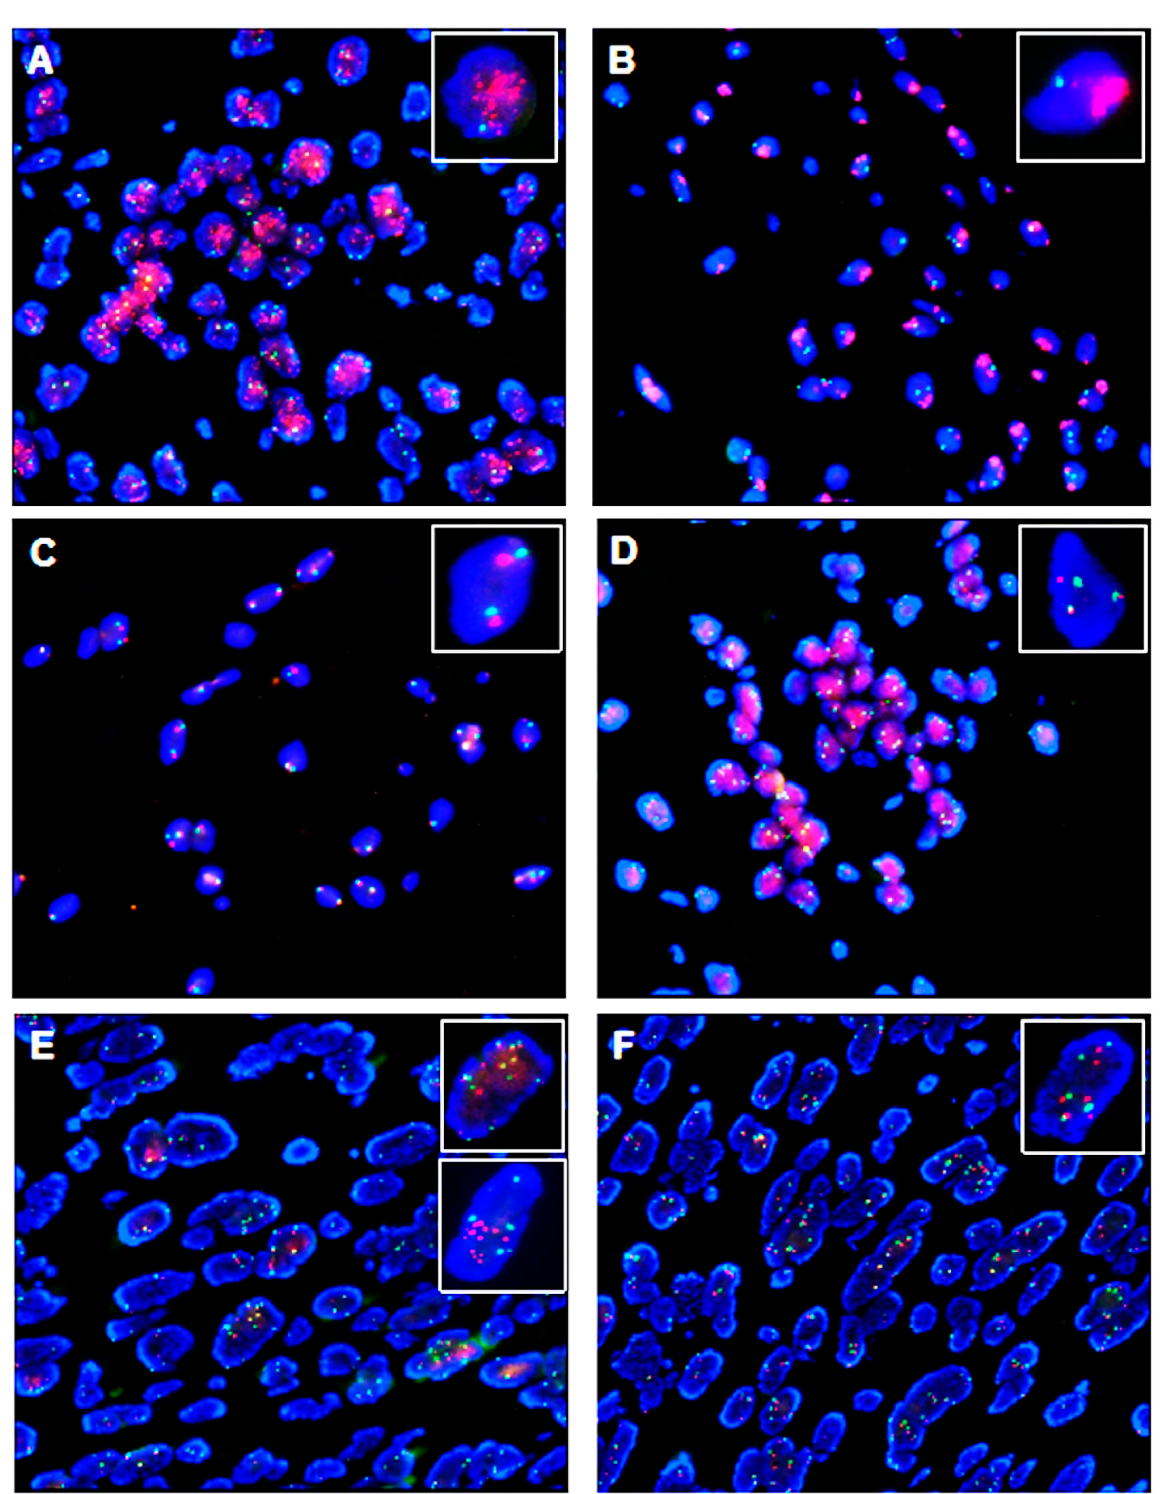
Figure 2. Patterns of MDM2 gene status by FISH assessment. MDM2 red signals and CEP12 green signals (Abbott molecular probes). Nuclei are counterstained with 4 ′ -6-diamino-2-phenylindole and appear blue. ( A ) MDM2 amplification with MDM2 > 10 and CEP12 = 2. Notably, several MDM2 gene dot-like signals are scattered over the whole nucleus. Focal areas with overlapping signals are also present. Overall, this pattern is consistent with gene localization on Dmin. ( B ) MDM2 amplifi- cation with several areas with crowded, overlapping signals arranged in clusters over the whole nucleus and two CEP12 signals. This pattern is typical of Dmin amplification as well. ( C ) No MDM2